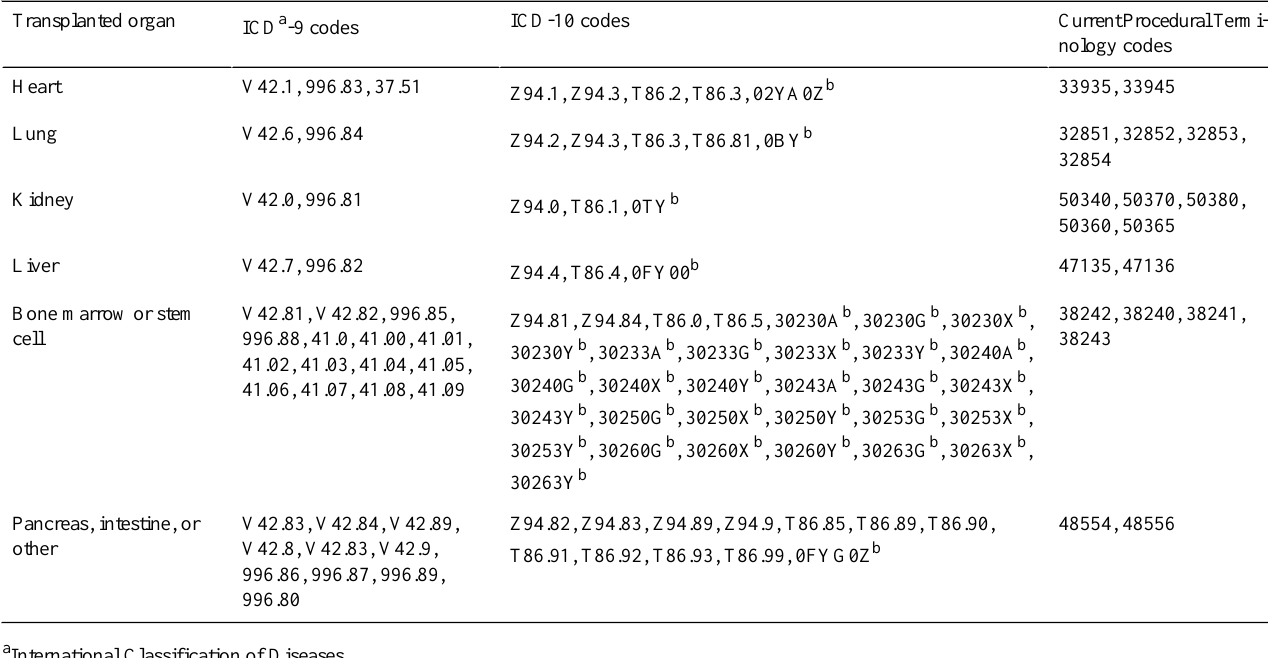
Table 1. List of the International Classification of Diseases and Current Procedural Terminology codes used to identify possible organ transplant recipients from the electronic health record.